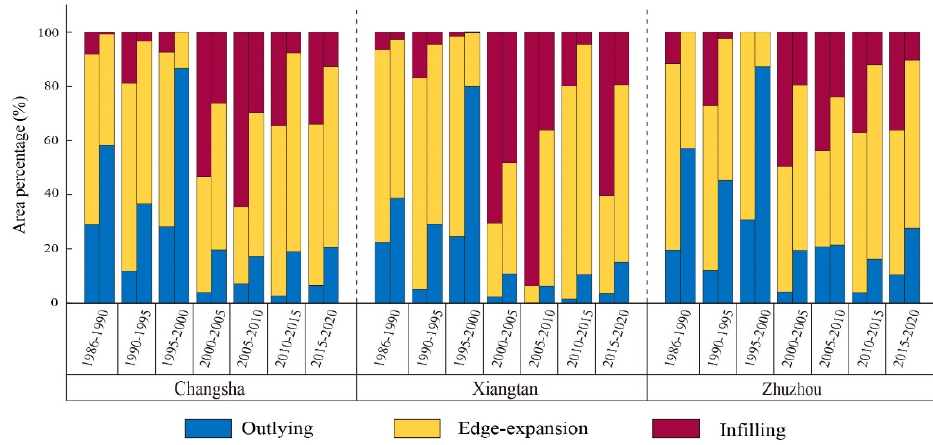
Figure 6. The differences in expansion morphology between urban and rural areas at the city level. In each city, the left and right columns are the results in urban and rural areas, respectively.